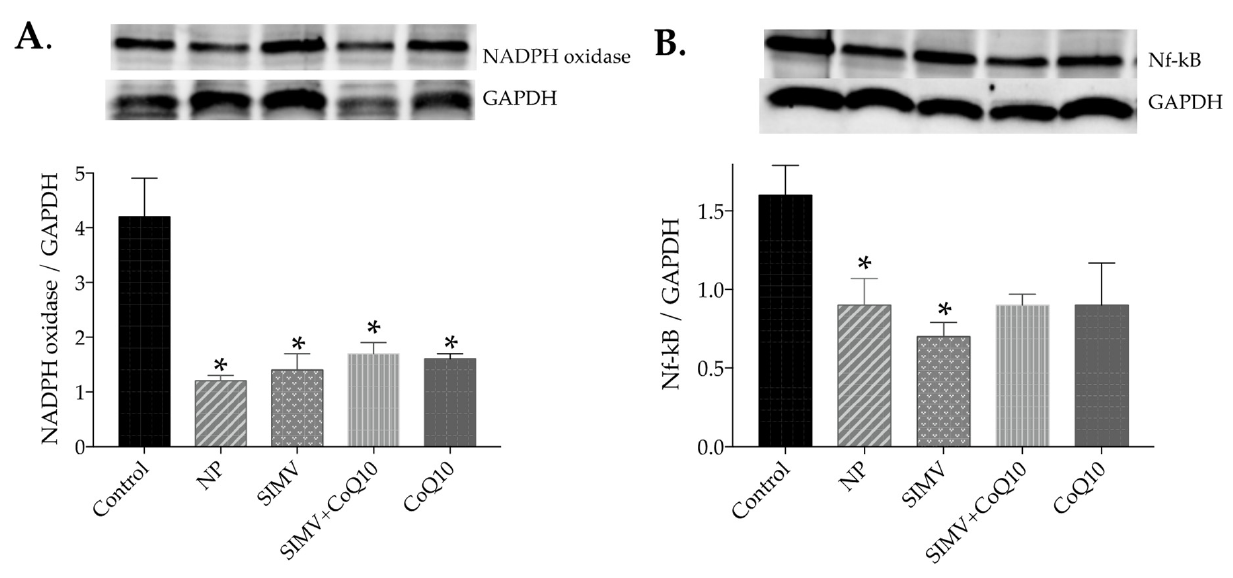
Figure 4. Expression levels and representative Western blot images of nicotinamide adenine dinu- cleotide phosphate (NADPH) oxidase ( A ) and nuclear factor kappaB (NF-kappaB) ( B ) in the heart of the control group and groups treated with empty nanoparticles (NP), simvastatin-loaded nanoparticles (SIMV), combination of simvastatin-loaded and coenzyme-Q10-loaded nanoparticles (SIMV+CoQ10), and coenzyme-Q10-loaded nanoparticles (CoQ10). * p < 0.001 compared to the control obese Zucker rats. Data are means ± SEM from 6 animals in each group.